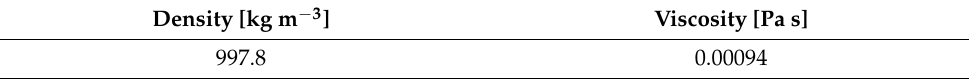
Figure 1. Morphology of the three helminth eggs considered (figure borrowed from Sengupta et al. [20], symmetry lines are added to original figure), ( a ) Ascaris suum (ASC), ( b ) Trichuris suis (TRI), ( c ) Oesophagostomum spp. (OES). Table 1. Material properties of tap water